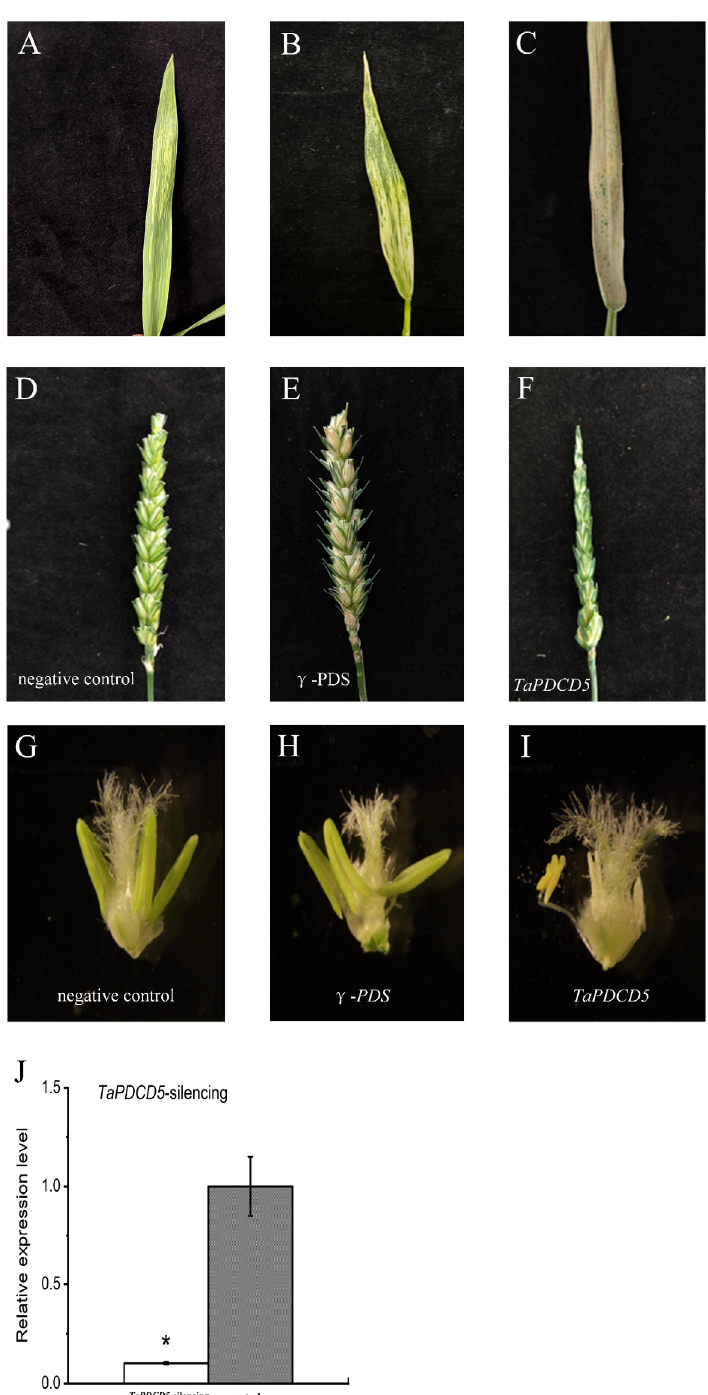
Figure 9. Functional verification of TaPDCD5 via BSMV-VIGS. ( A ) Leaf characteristics of positive control ( PDS gene-silenced) plants. ( A ), Early stage of positive control plants. ( B ), Metaphase of positive control plants. ( C ), Late stage of positive control plants. ( D – F ) Fertility of ears. ( D ), Negative control. E, Positive control. F, TaPDCD5 -silenced plants. ( G – I ) Anther morphology. ( G ), Negative control. ( H ), Positive control. L, TaPDCD5 -silenced plants. ( J ) Relative expression of gene-silenced plants. Significant differences were determined by Student’s t -test (* p < 0.05).